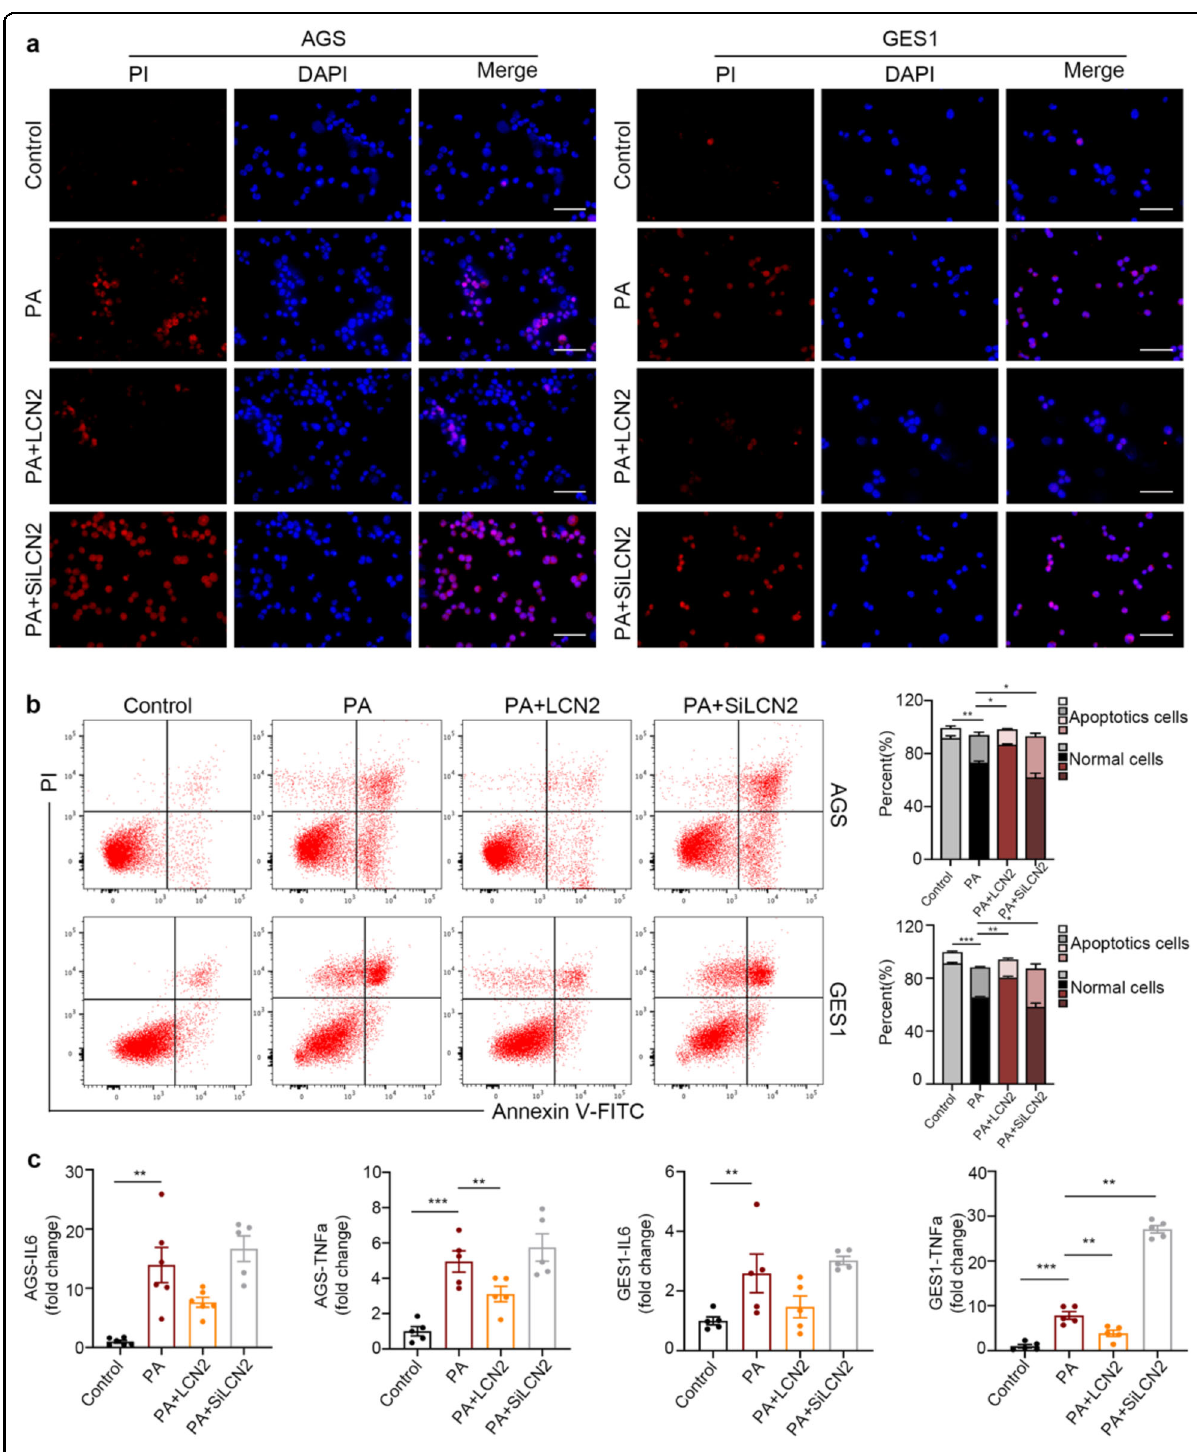
Fig. 5 LCN2 protects gastric epithelial cells (AGS, GES1) from palmitic acid-induced apoptosis and in fl ammatory state. a AGS and CES1 cells groups (NC, LCN2, siRNA-LCN2) were treated with 300 μ M PA for 12h, the blank group (Control) was added to the fatty acid free medium, and as assayed via staining with DAPI/PI, signi fi cant protection against PA-induced apoptosis was afforded by LCN2. Channels are: DAPI nuclear stain (blue) and apoptosis by PI (red); ×400 magni fi cation. b Cell apoptosis was analyzed by fl ow cytometry using Annexin V/FITC with the same treatment. Columns (right panel) represent the average percent of Annexin V positive from three independent experiments. c The level of IL6 and TNF α in each groups. The data are expressed as the mean ± s.e.m. * P < 0.05, ** P < 0.01, *** P <